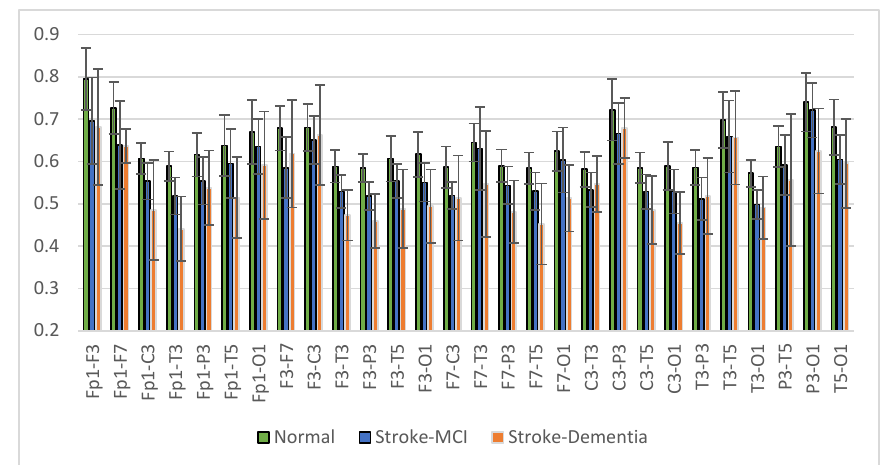
Figure 16. Left intrahemispheric coherence value of each electrode pair.